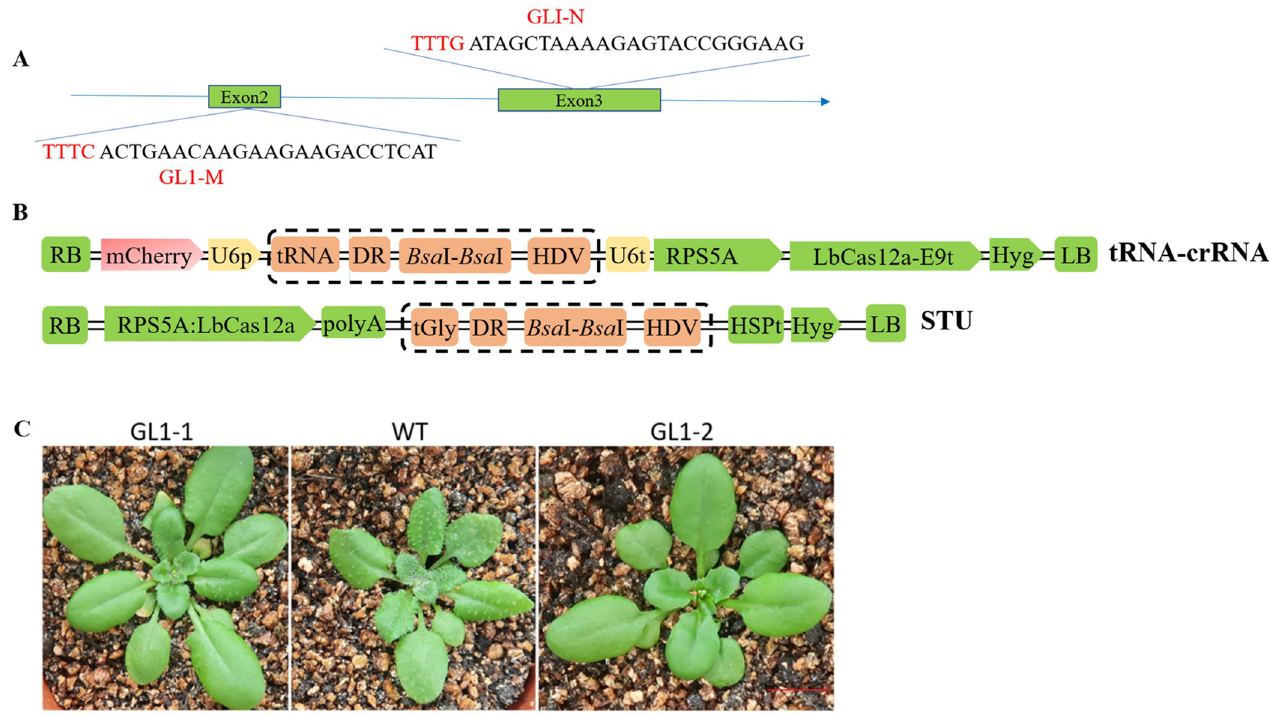
Fig 1. Editing efficiencies of different crRNA expression strategies. (A) The two target sequences of GL1-M and GL1-N. (B) Schematic diagram of T-DNA structure of different crRNA expression strategies. RB and LB, T-DNA right and left borders, re-spectively. U6p, Arabidopsis U6 gene promoter. E9t, pea (Pisum sativum) rbcS-E9 terminators. HSPt, Arabidopsis HSP18.2 terminators. (C) Phenotypes of representative T1 mutant plants with tRNA-crRNA fusion strategy. GL1-1, partial glabrousness. WT, wild type. GL1-2, complete glabrousness. The length of the red line is 1cm.